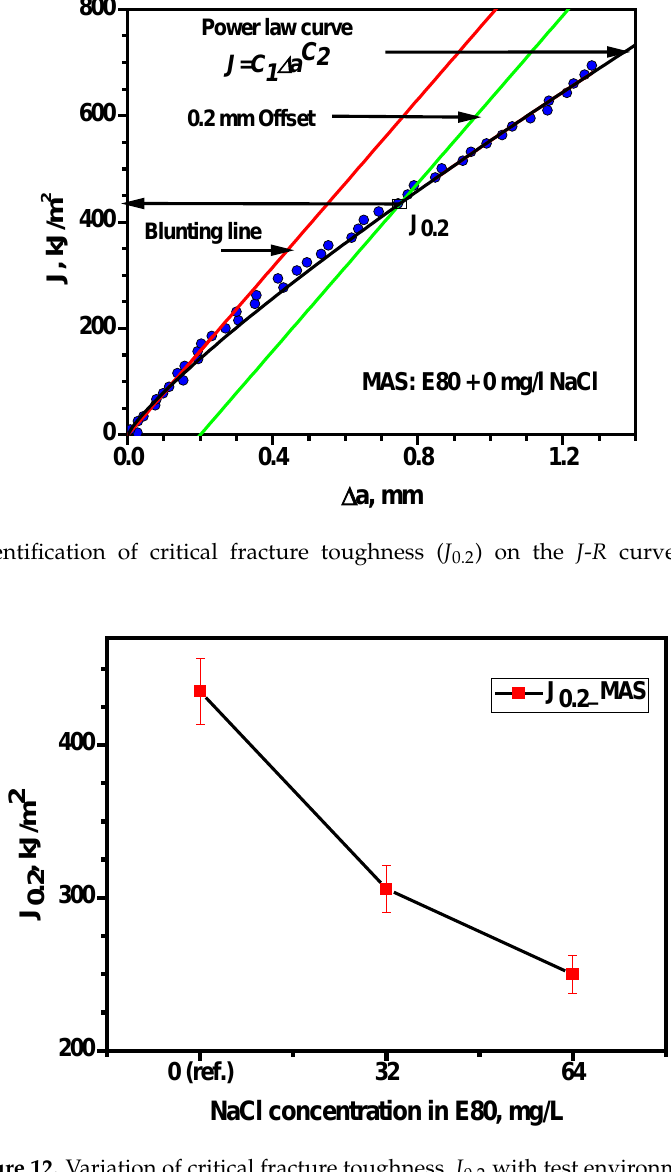
Table 6. Qualifying criteria for fracture toughness ( J IC ) for MAS in E80 fuel ethanol environment. B: specimen thickness; b o : un-cracked ligament; dJ